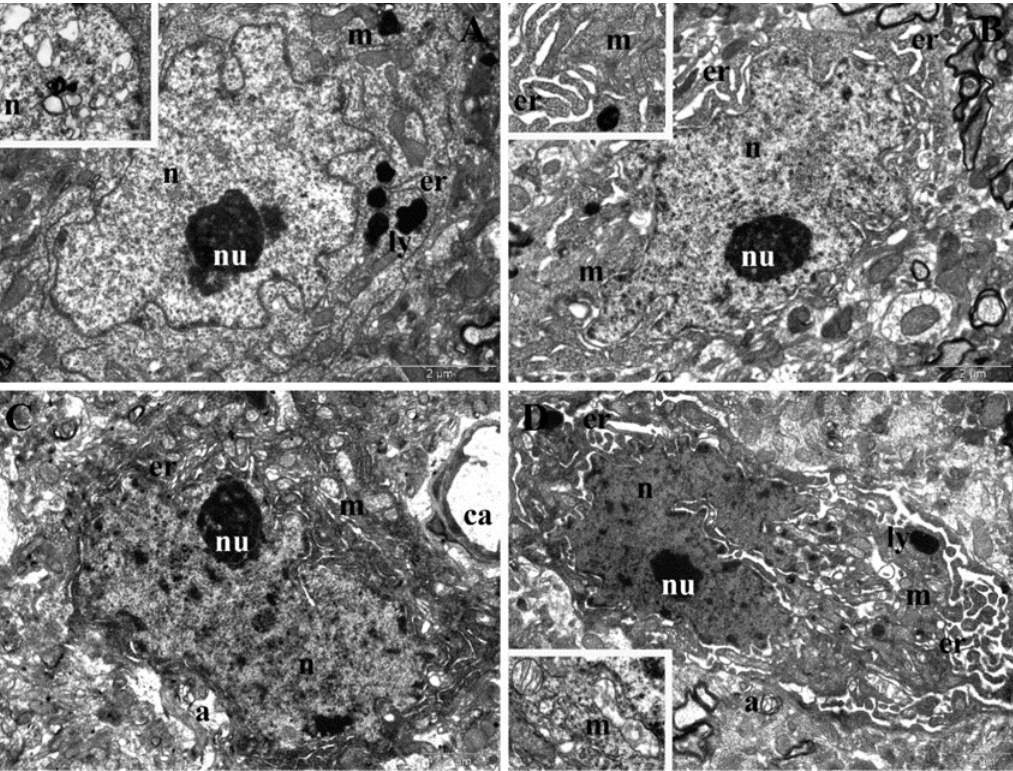
Figure 11. TEM images presenting ultrastructural changes recorded 15 days after the end of the experimental treatment. ( A ) Neurons from the frontal cortex of rats treated with the low dose of NPs (T60 D1 group). ( B ) Neurons from the hippocampus of rats treated with the low dose of NPs (T60 D1 group). ( C ) Neurons from the frontal cortex of rats treated with the high dose of NPs (T60 D2 group). ( D ) Neurons from the hippocampus of rats treated with the high dose of NPs (T60 D2 group). a–autophagosome; ca–capillary; er–endoplasmic reticulum; ly–lysosome; m–mitochondrion; n–nucleus; nu–nucleolus; rbc–red blood cell.